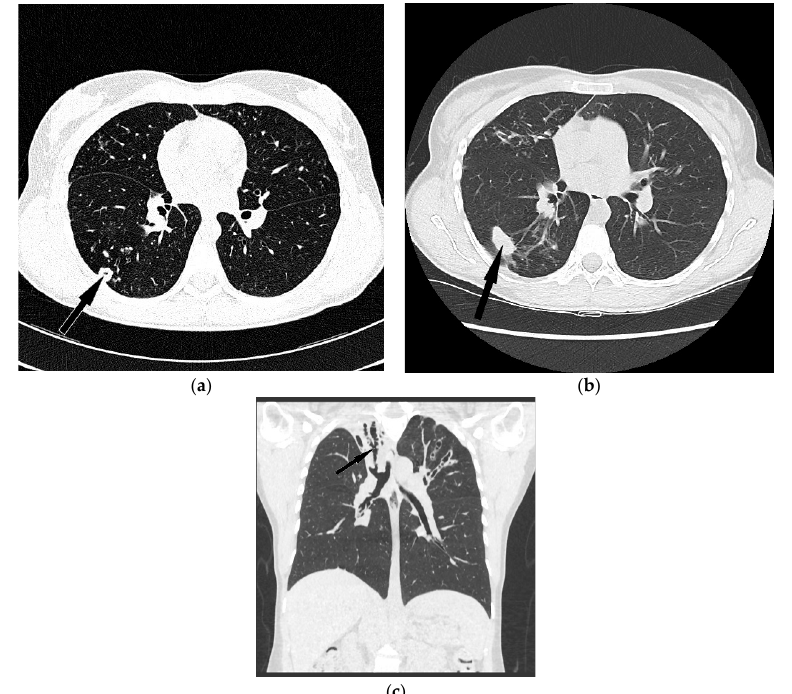
Figure 2. Forty two-year old female with cystic fibrosis and NTMLD (cavitary form). ( a ) CT scan (lung window, axial view) shows thick walled cavity in the 6th segment of right lung (black arrow) which may suggest pulmonary NTM infection. ( b ) CT scan (lung window, axial view) after 6 years in the place of previously visible cavity shows consolidation (black arrow). ( c ) CT scan (lung window, coronal image) presents upper right lobe collapse with cystic bronchiectasis involving the whole bronchial tree (black arrow).